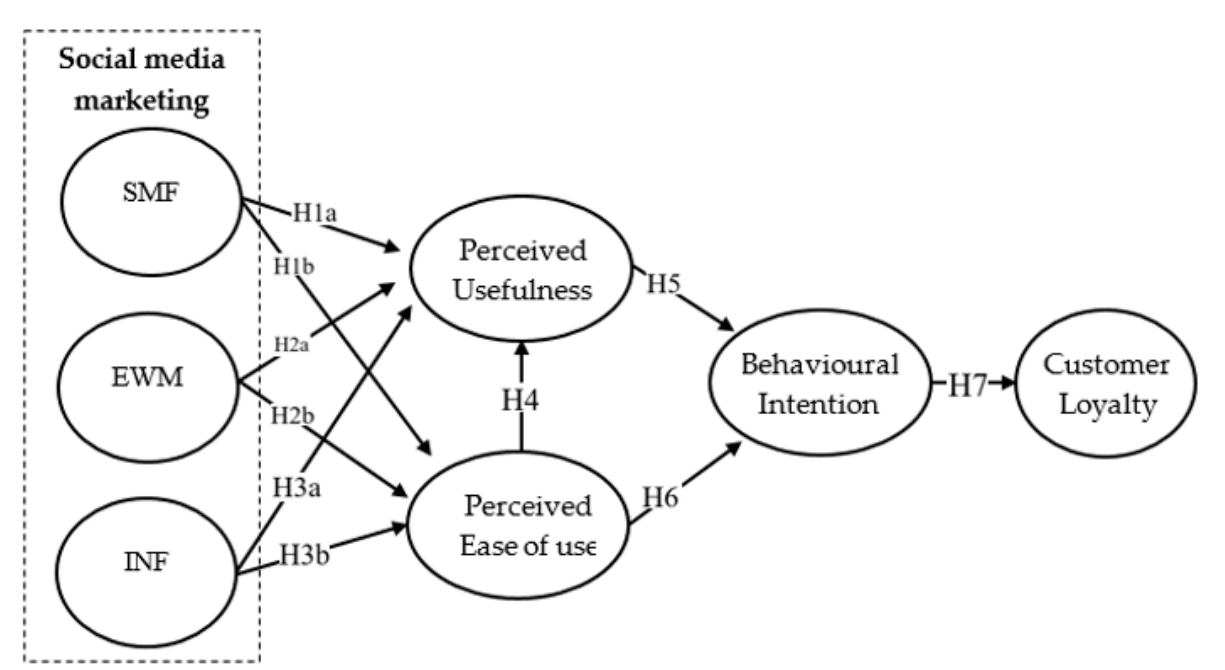
Figure 1. Our conceptual customer loyalty framework.